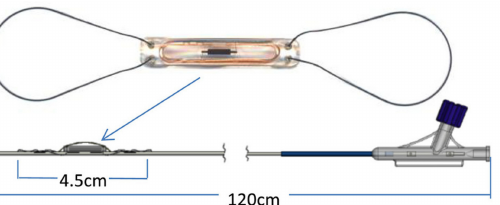
Figure 1. The CardioMEMS HF system pulmonary artery pressure sensor. Reprinted from ESC Heart Failure Volume 7, Issue 3, Cowie et al., Rationale and design of the CardioMEMS Post- Market Multinational Clinical Study: COAST, pages 865–872, Copyright 2020, with permission from Wiley